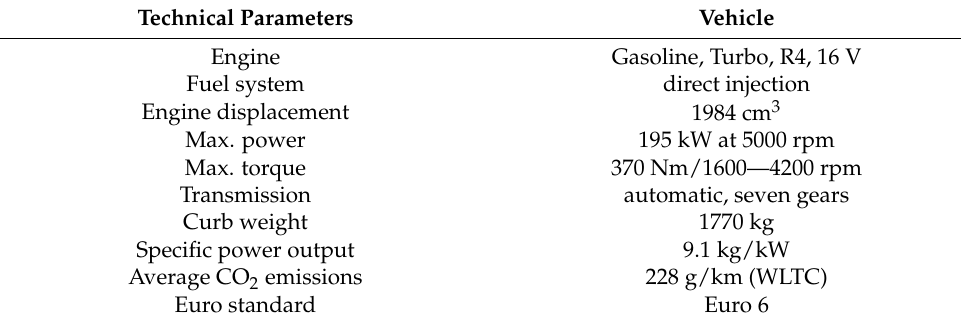
Table 1. Technical parameters of the tested vehicles.